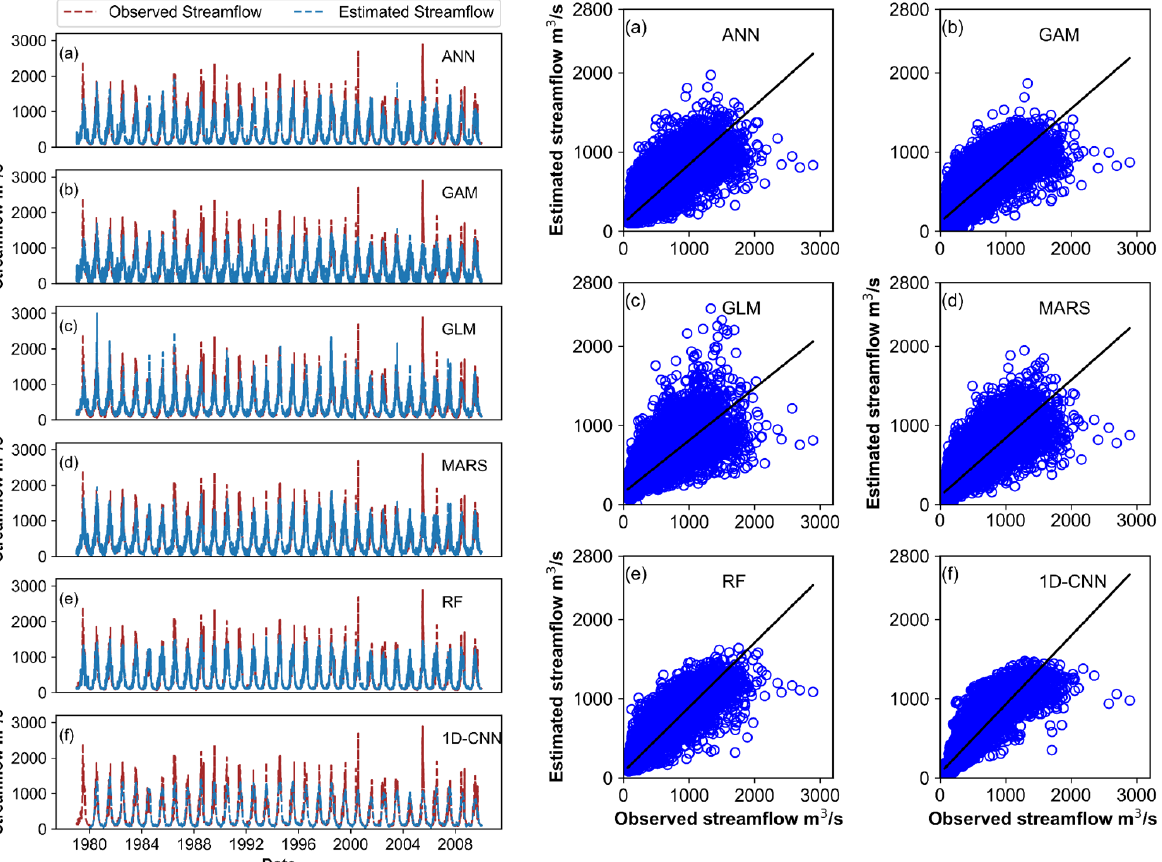
Figure 5. Comparison of observed and simulated streamflow for all six models (ANN, GAM, GLM, MARSs, RF, and 1D-CNN) under rainfall scenarios R 0